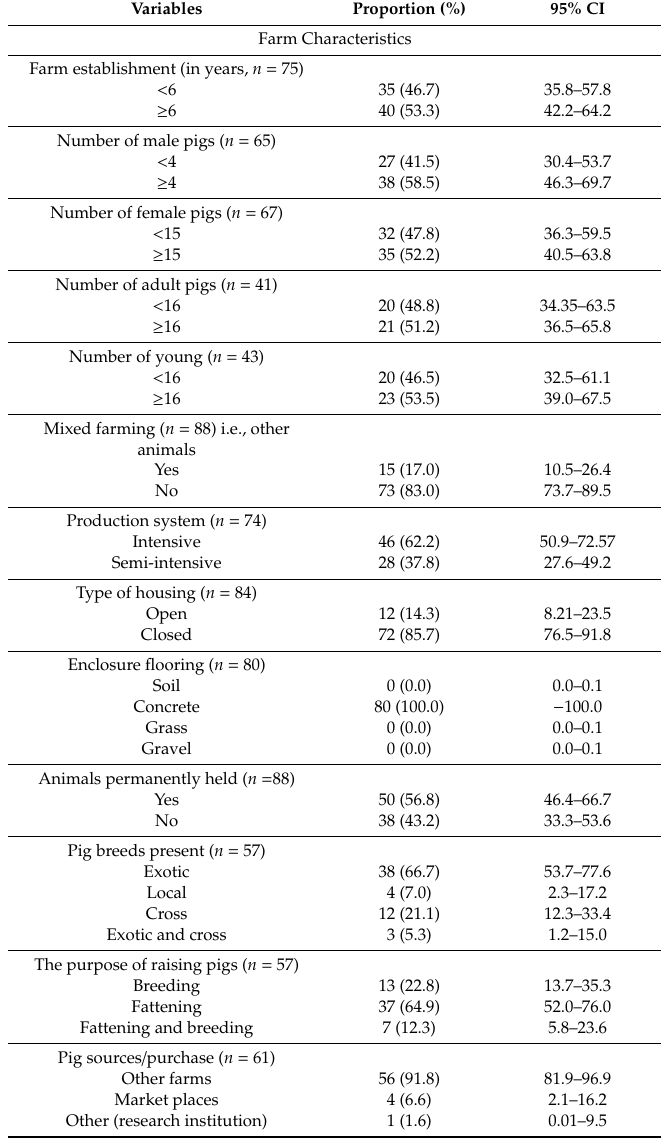
Table 2. Farm characteristics and management practices on the studied pig farms in Ogun State,